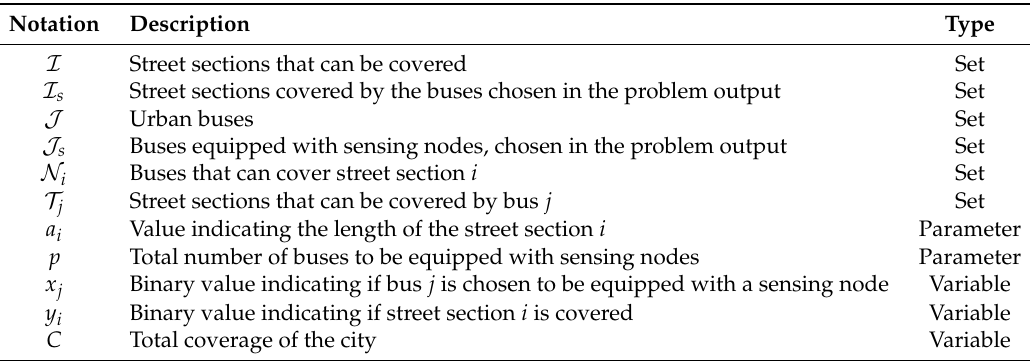
Table 1. Notations used in this